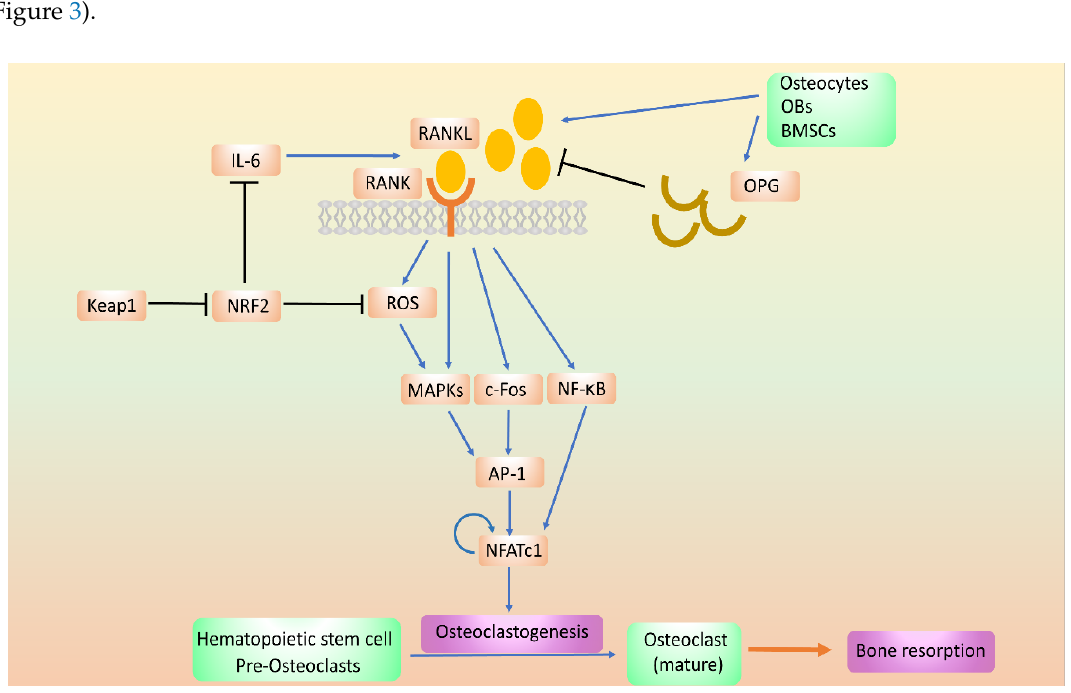
Figure 3. The regulation of signal pathways in osteoclastogenesis. In osteoclast (OC) differentiation, the RANKL/RANK pathway that regulate the downstream intracellular markers such as mitogen- activated protein kinases (MAPKs), c-Fos, and NF-κB, which contribute the OC maturation. In the pathway, NRF2 could reduce the osteoclastogenesis by ROS